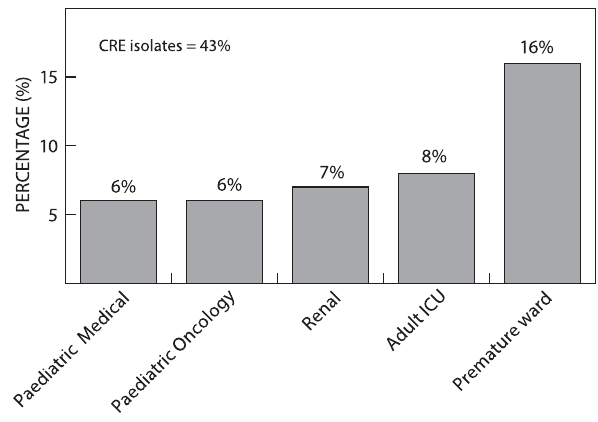
Figure 1: Top 5 areas with the highest CRE prevalence (2015).